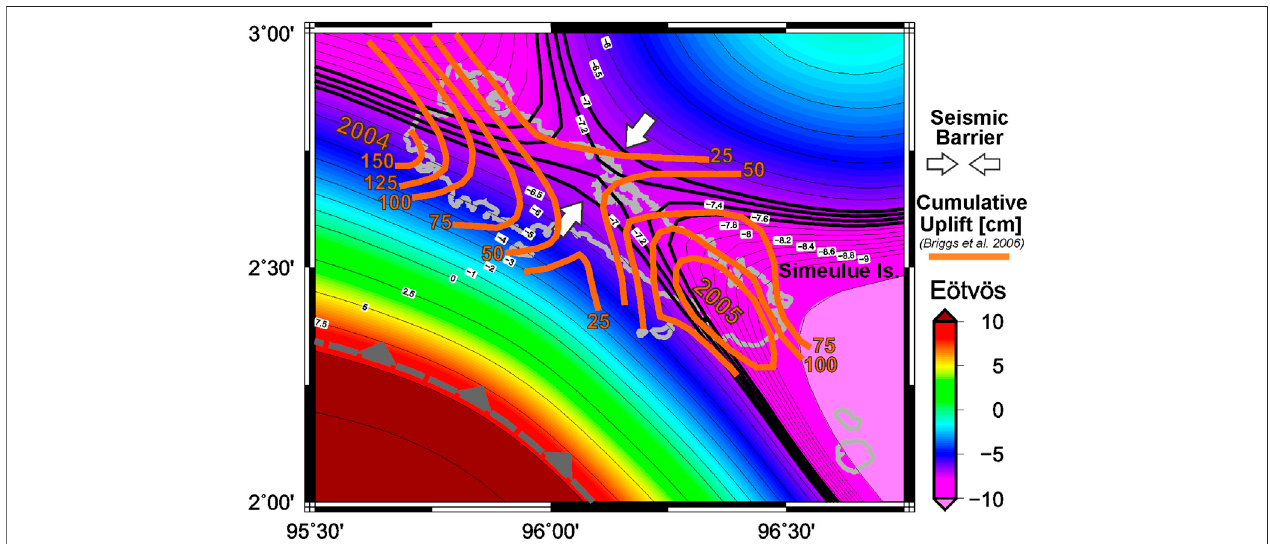
FIGURE 7 | Cumulative uplift (solid orange contours) from Briggs et al. (2006), recorded after the 2004 Sumatra-Andaman and the 2005 Simeulue-Nias earthquakes, superimposed to the topography corrected vertical gravity gradient (Tzz) obtained from GOCE model GO_CONS_GCF_2_DIR_R6 up to N (cid:1) 200 (Bruinsmaetal.,2014).Whitearrowsindicatetheexistenceofaseismicbarrierthatarrestedrupturepropagation.Notethesaddlestructureofthecumulativeuplift(incm) that seems to replicate the gravimetric structure, coinciding the minimum in the center of the Island with the local maxima in Tzz interpreted as a seismic barrier to rupture